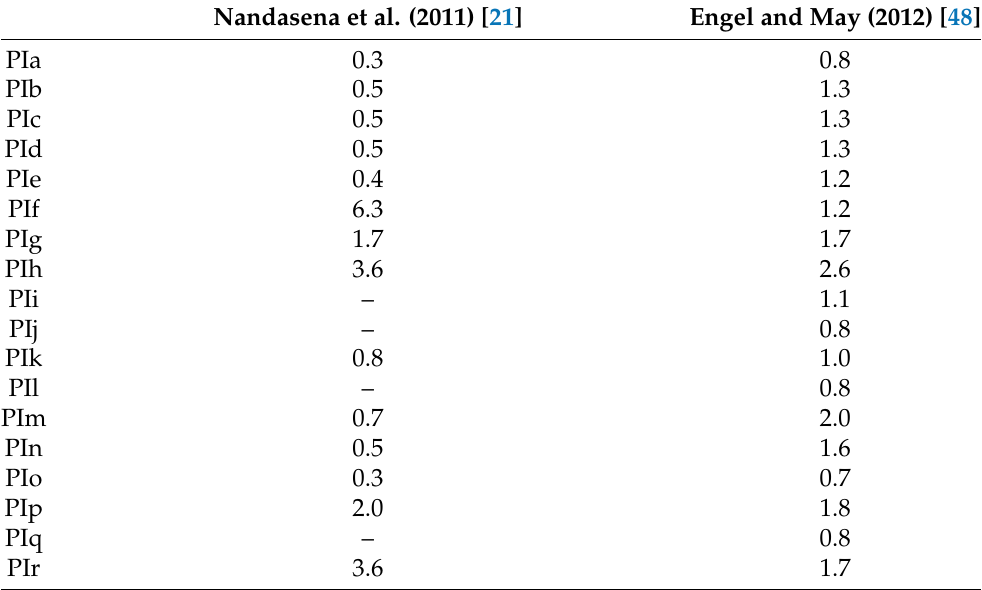
Table A20. Minimum wave heights H m (m) required to displace the boulders of the Punta Pizzo headland.